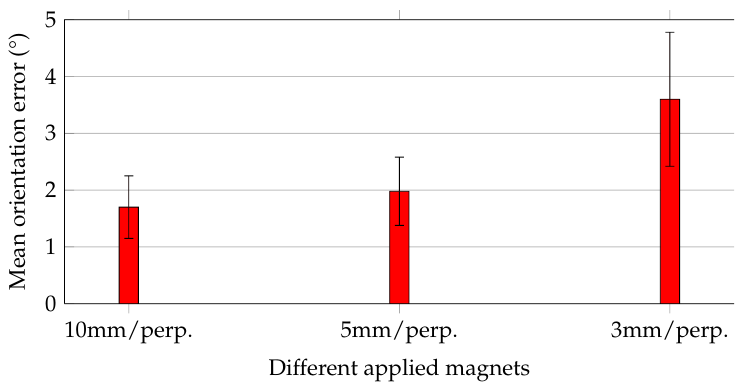
Figure 5. Representative measured trajectories using the 10mm movement direction.